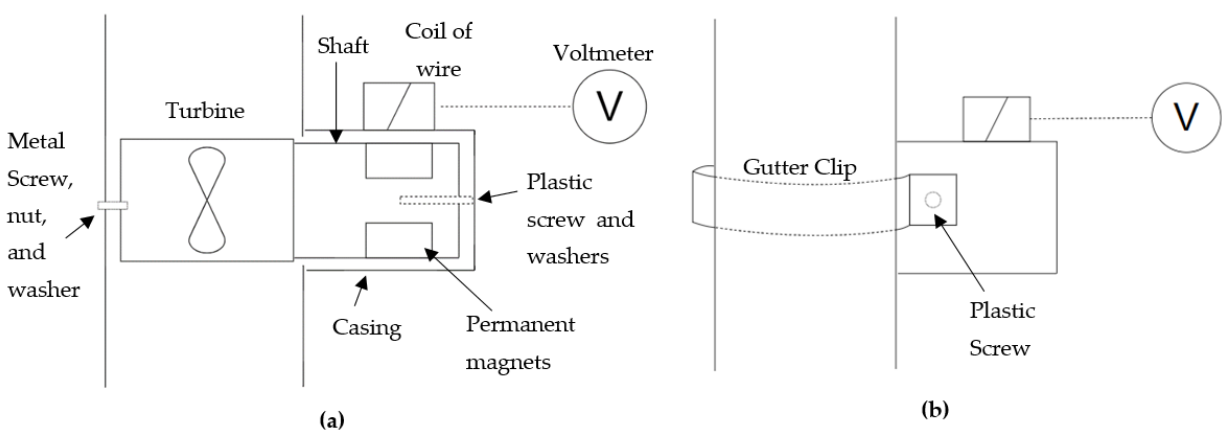
Figure 8. Attachment schematics: ( a ) schematic of inside attachment and support; ( b ) schematic of outside attachment and support.